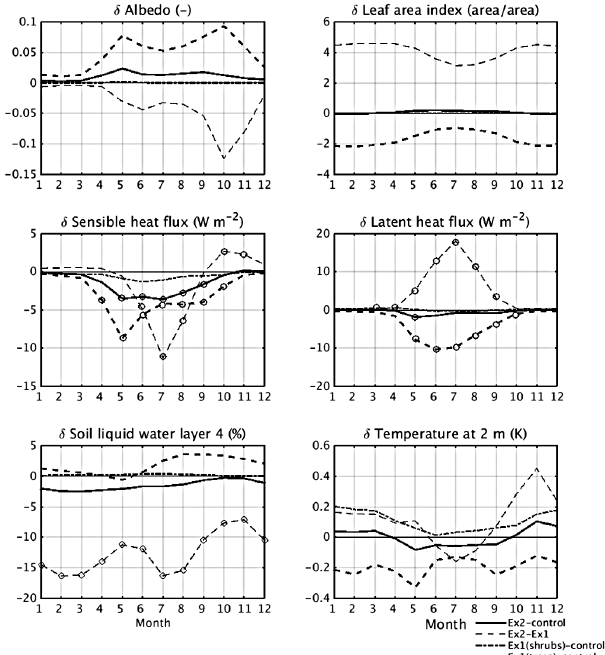
Figure 10. Seasonal changes in 10-year monthly average surface and near-surface variables for each area with changed vegetation. Average of all vegetation changes shown by the thick black line (Ex 2 − control), black circles indicate significant results at the 95% confidence